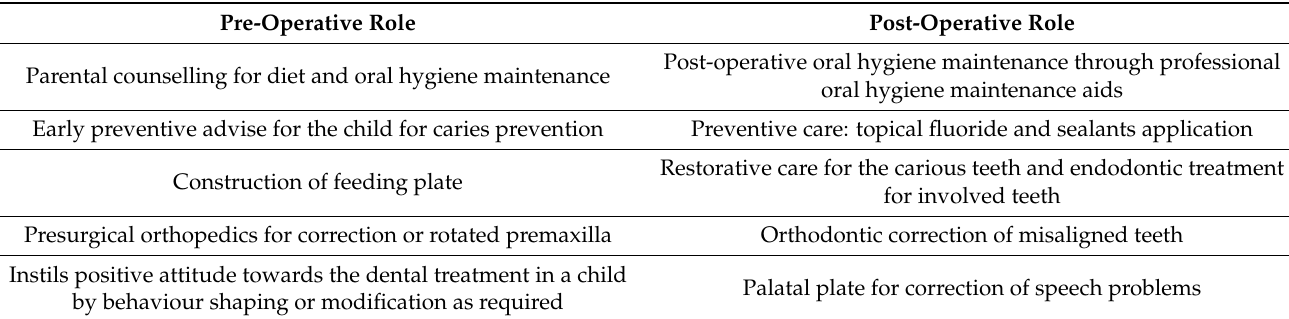
Table 1. Role of the pediatric